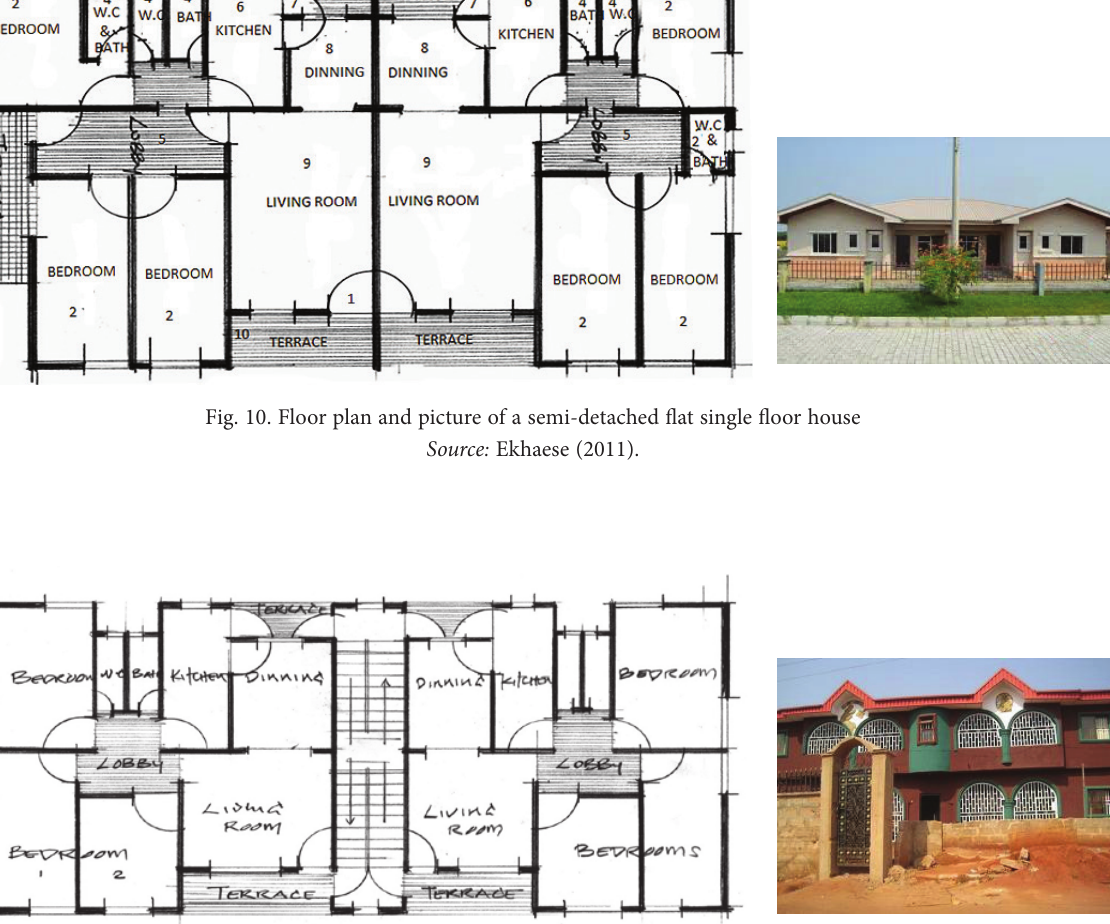
Fig. 11. Floor plan and picture of a typical semi-detached flat double floor Source: Ekhaese (2011).